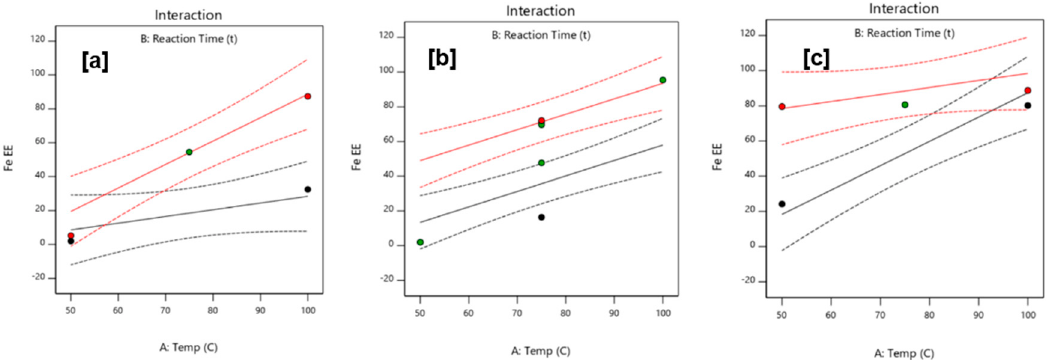
Figure 5. Parametric interactions of temperature and reaction time at ( a ) low, ( b ) mid, and ( c ) high reagent concentration levels.